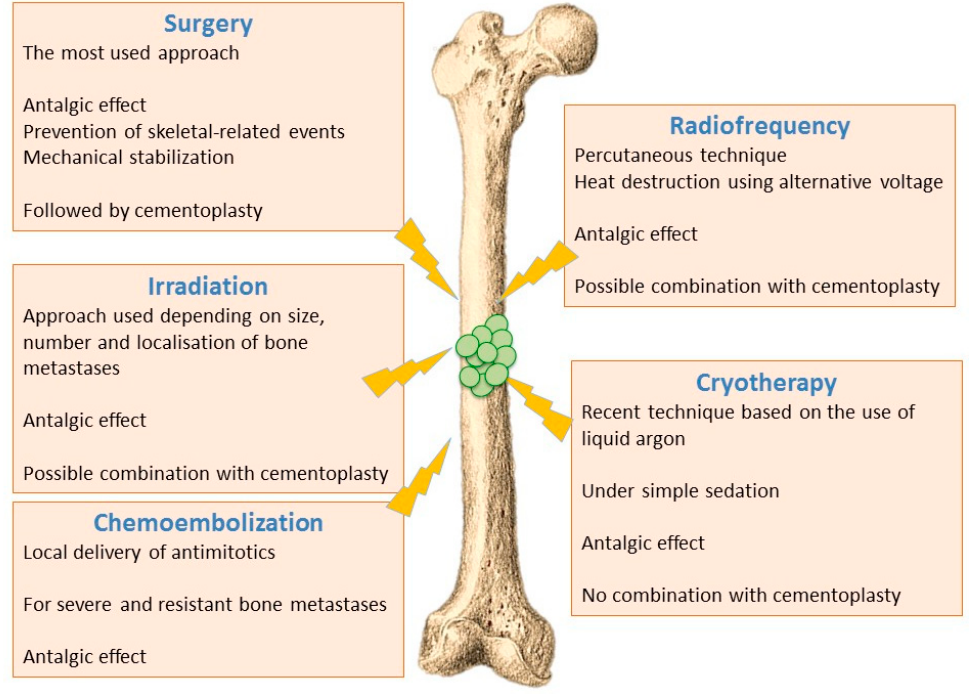
Figure 2. Tumours ablative therapies. They are selected according to the clinical status of patients, the tumour resistance, characteristics of metastases in terms of size/number/localization, and therapeutic objectives such as preventing development of skeletal-related events, achieving analgesic effect and getting a mechanical stabilization (see references [70–75]).